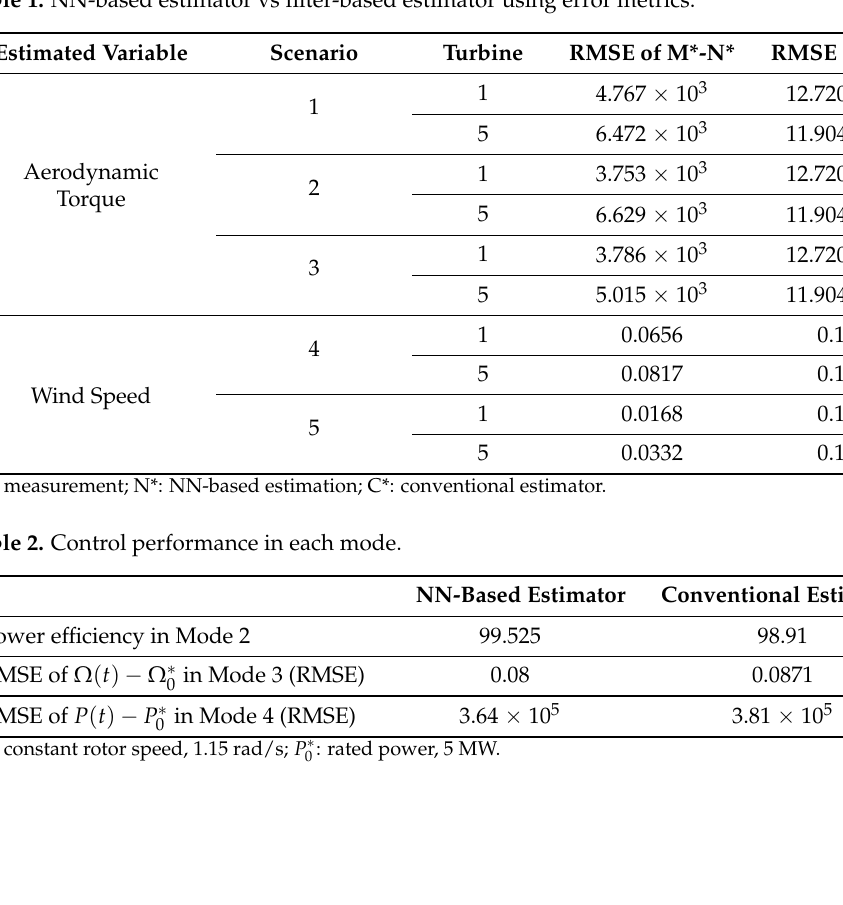
Table 1. NN-based estimator vs filter-based estimator using error metrics.